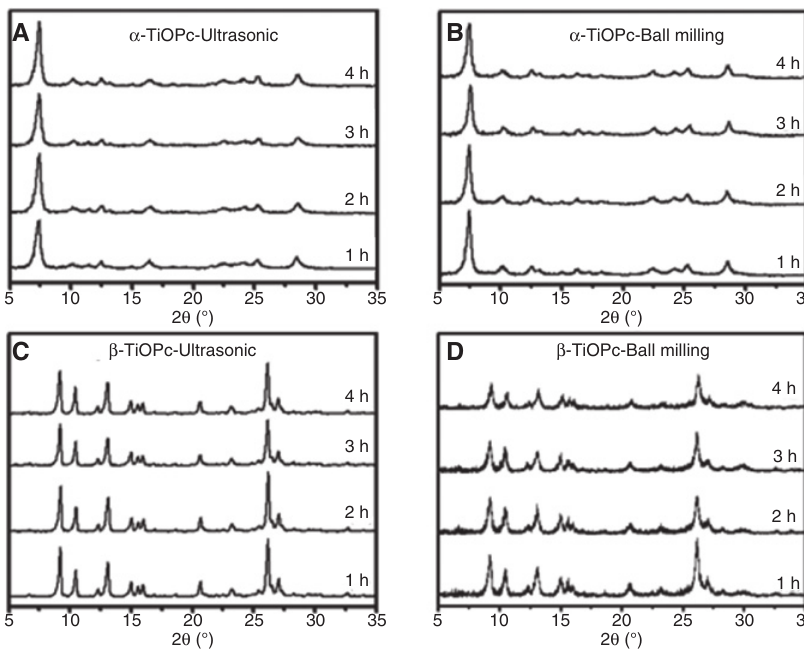
Figure 3: Characterization of crystal form stability. The XRD patterns of the α - and β -TiOPc NPs before and after ultrasonic treatment (A, C) and ball milling (B, D) for 1–4 h, respectively.